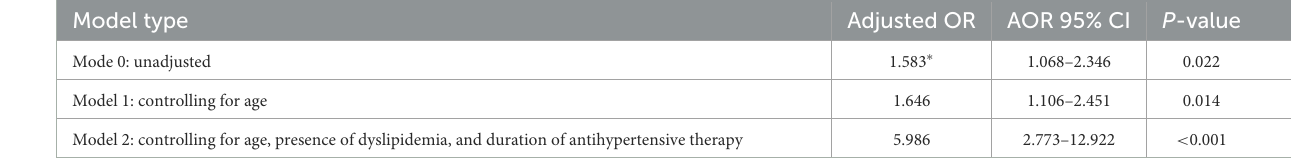
TABLE 8 The association of statin use with controlled BP in bivariable and multivariable binary logistic regression analyses among patients with hypertension attending the outpatient clinic at FHCSH, northwest Ethiopia. Model type Adjusted OR AOR 95% CI P